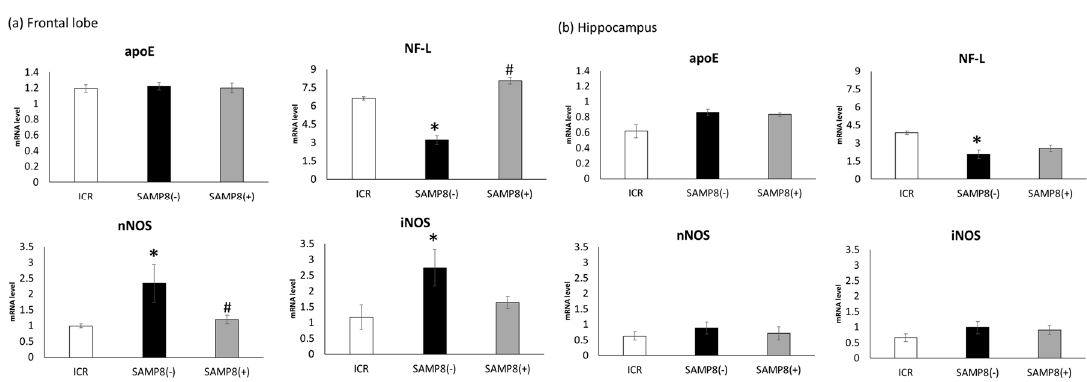
Figure 4. E ff ects of Coriandrum sativum seed extract on messenger (m)RNA expression levels of apolipoprotein E (apoE), neurofilament light (NF-L), inducible nitric oxide synthase (iNOS), and neuronal (n)NOS in the frontal lobe and hippocampus of ICR and SAMP8 mice. Values are expressed as the mean ± SEM. An asterisk indicates a significant di ff erence compared to the ICR group ( * p < 0.05). A hash mark (#) indicates a significant di ff erence compared to SAMP8( − ) mice. ICR, Institute of Cancer Research; SAMP8( − ), SAMP8 mice without C. sativum supplementation; SAMP8( + ), SAMP8 mice with C. sativum